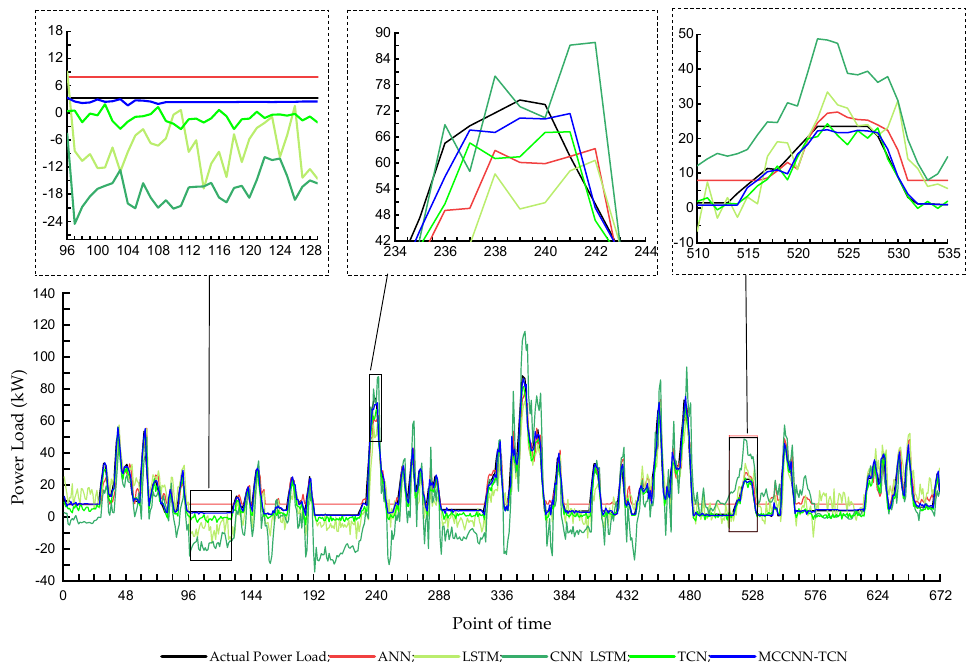
Figure 7. Comparison of f orecasting results of load models in 7 days.